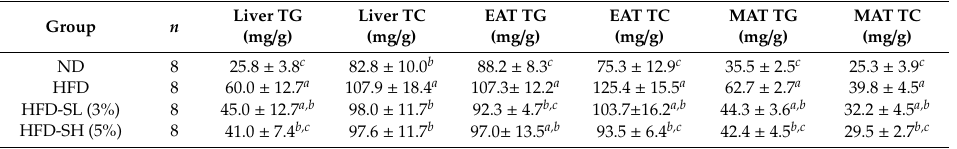
Table 6. E ff ects of the Spergularia marina Griseb powder (SMP) on the lipids in liver and adipose